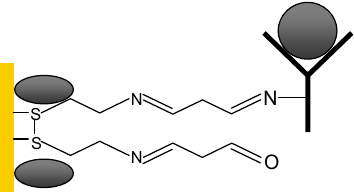
Figure 2. Schematic diagram of the integration of cystamine